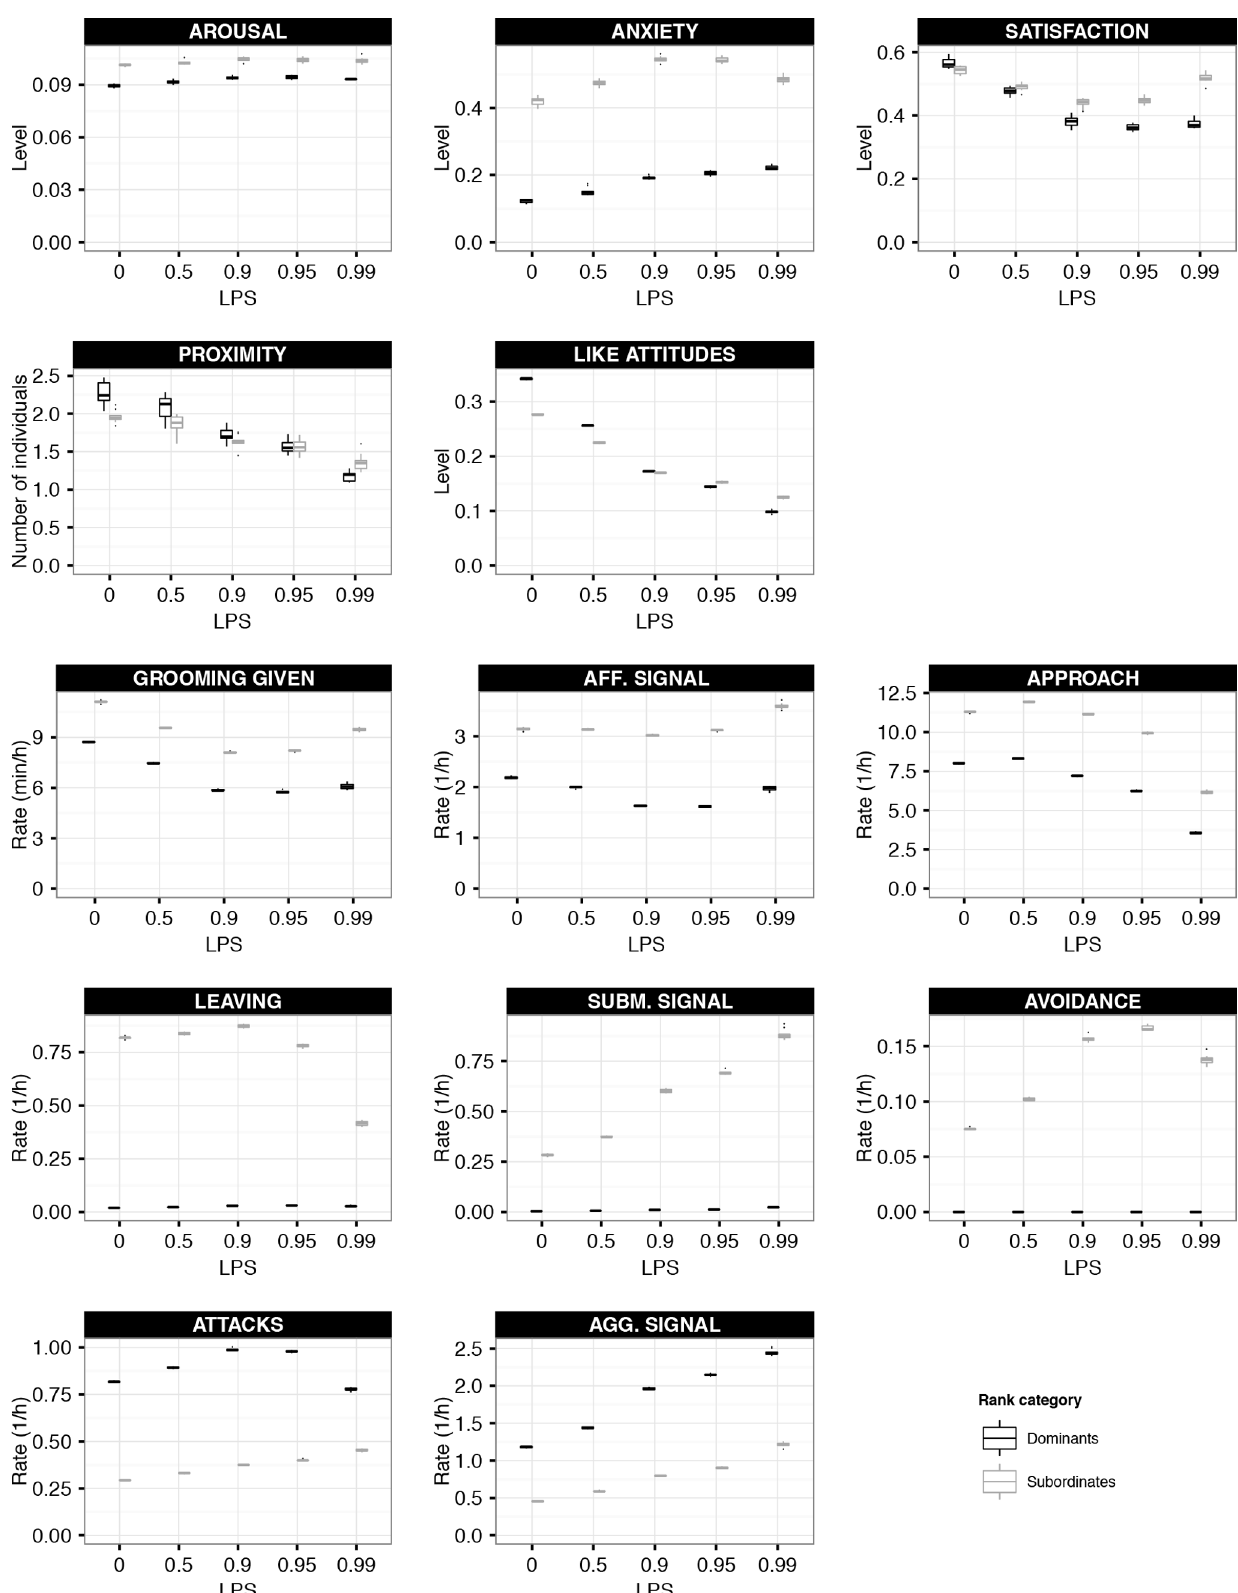
Figure 4. Emotional levels and behavioral rates per rank category. This figure shows the averaged levels of the emotional state and rates of behavior for dominants (black box-plots) and subordinates (grey box-plots) at different settings of selectivity (LPS). Proximity is measured as the